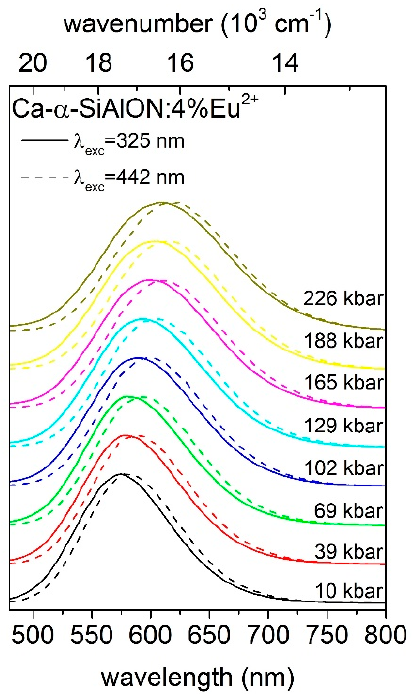
Figure 10. Pressure dependent emission spectra of Ca 0.8 Si 9.6 Al 2.4 O 0.8 N 15.2 :4%Eu 2+ . excited at 325 nm (solid line) and 442 nm (dashed line).